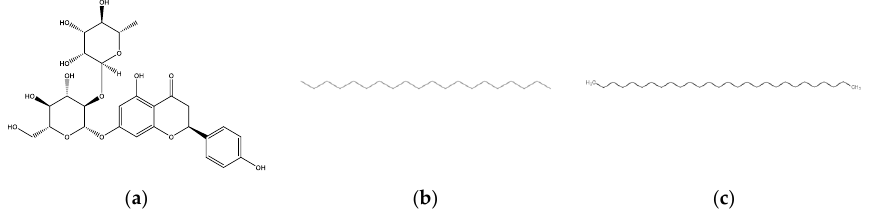
Figure 10. Structure of bioactive compounds ( a ) Naringin ( b ) Eicosane and ( c ) Octacosane.